Question: Sum up the contents of this chart in one sentence.
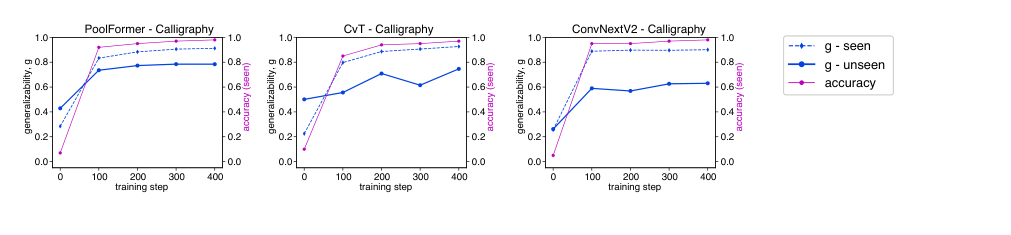
Answer: Generalization across fine-tuning epochs for all studied networks. We plot gseen and test-set accuracy (using seen classes) for reference. Notice how gseen is higher for all networks, as expected. This demonstrates that our g metric is able to capture the ability of the networks to generalize to unseen classes.